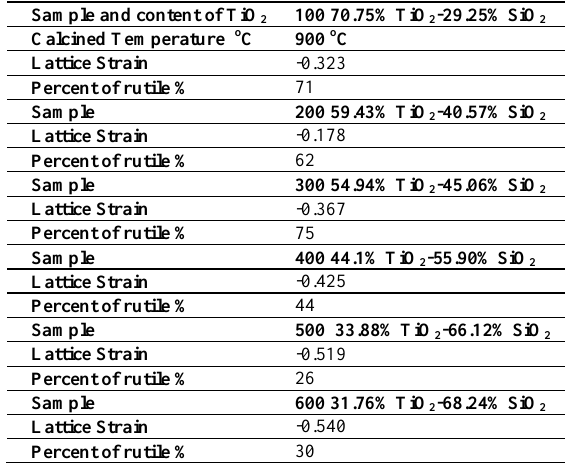
Table 4. The lattice strain and rutile content obtained in different TiO2 content in composite.